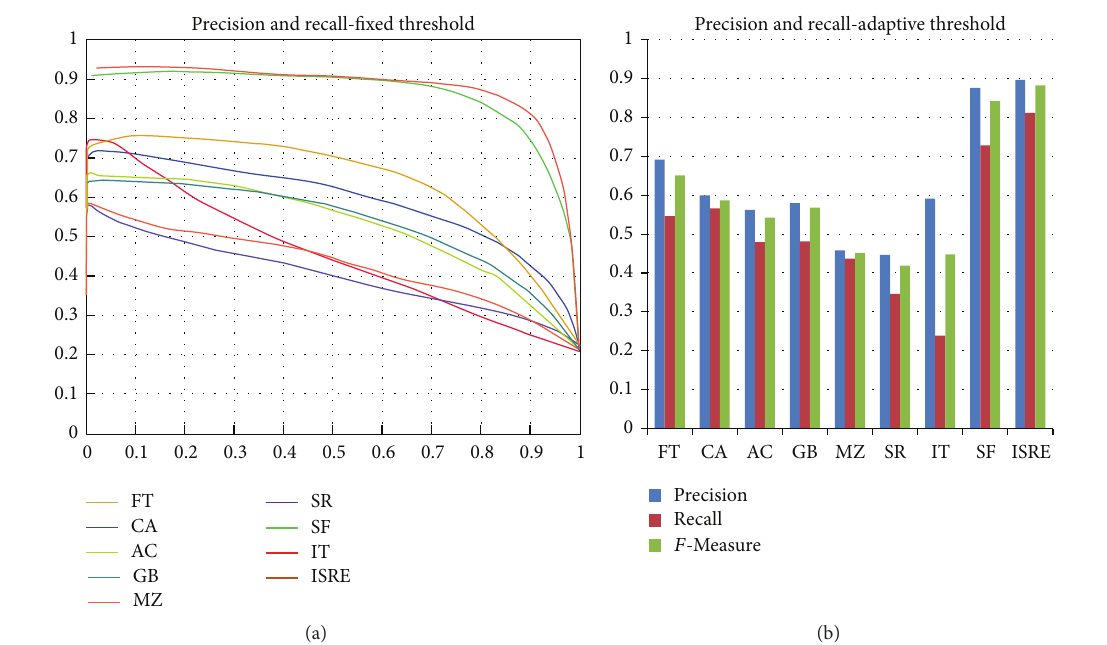
Figure 5: Comparison results of recall, precision, and 𝐹 -Measure